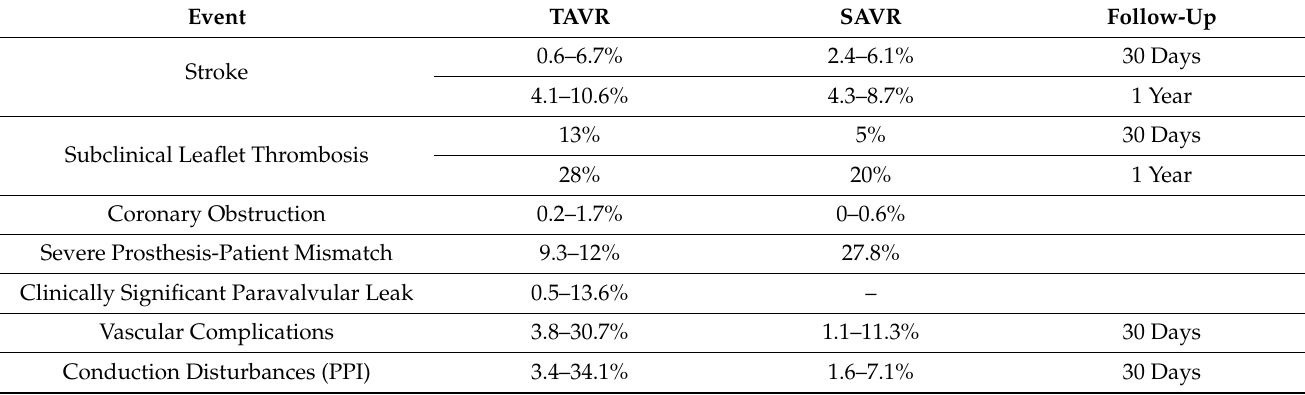
Table 2. Rate of adverse events after transcatheter aortic valve replacement (TAVR) and surgical aortic valve replacement (SAVR) reported in randomized controlled